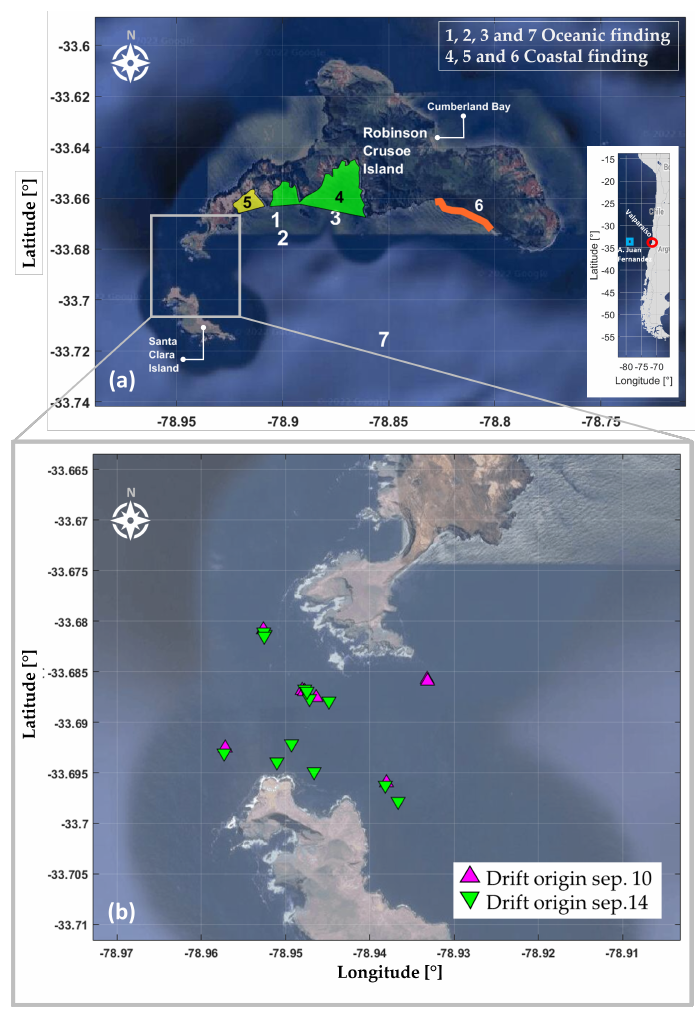
Figure 1. Study area and drifter deployments. ( a ) Juan Fernández Archipelago. Colored areas indicate locations where accident remains were found. ( b ) Geographic location of drifter deployments on 10 September (magenta triangles) and 14 September (green triangles)